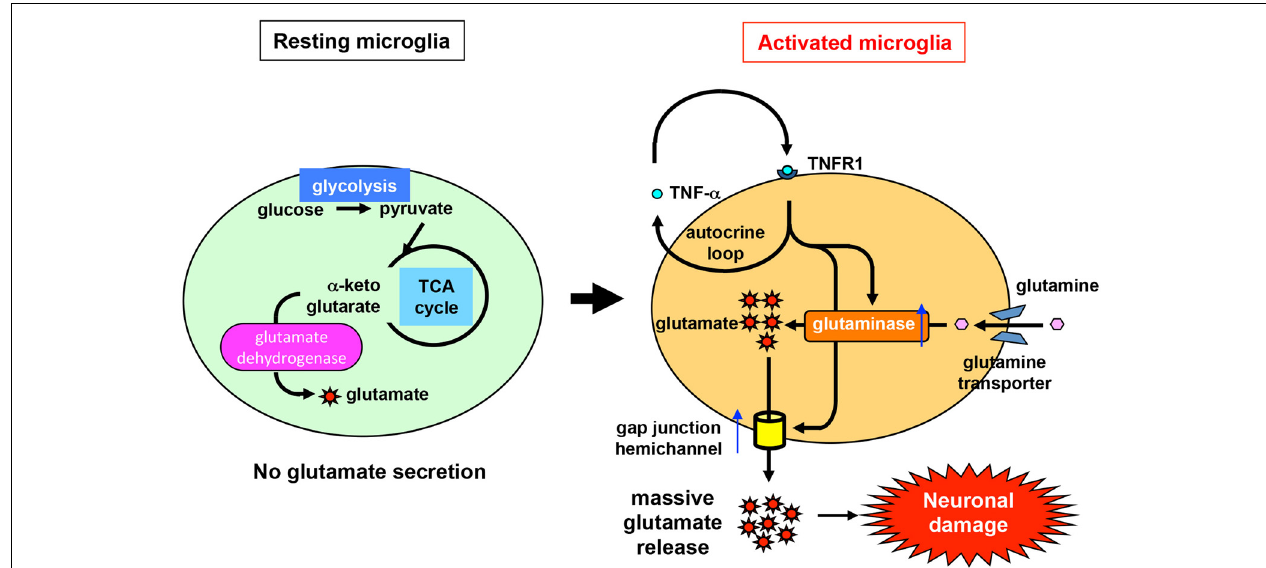
FIGURE 1 | Mechanism of glutamate production and release by activated microglia. Like other types of cells, resting microglia use glutamate dehydrogenase to synthesize glutamate from intracellular α -ketoglutarate in order to maintain a physiologically normal level of glutamate. Under resting conditions, microglia release very little glutamate into the extracellular space. By contrast, under pathological conditions,